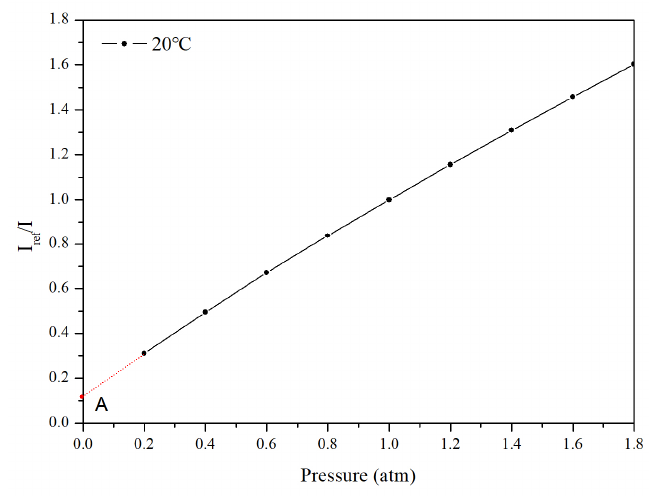
Figure 4. The Stern-Volmer (S-V)curve of the P(HFIPMA) sample measured at 20 ◦ C. Table 2. Pressure sensitivity of five kinds of pressure-sensitive paint (PSP) samples at different temperature.